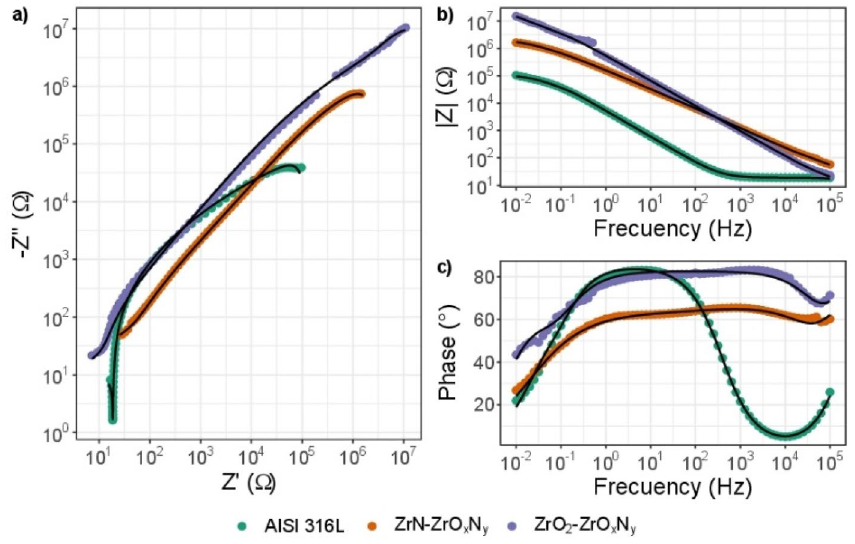
Figure 17. Nyquist diagram obtained from the impedance test for coated and uncoated samples in NaCl solution, ( a ) Nyquist impedance ( b ) Bode and ( c ) Bode plots; the solid line is the fit with the equivalent circuit.